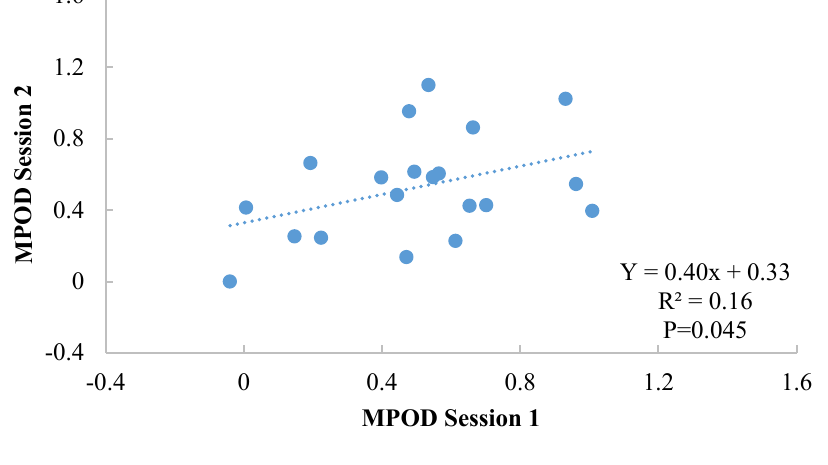
Figure 2. Illustration of the correlation between sessions 1 and 2 for Subgroup 1 (11 examiners).